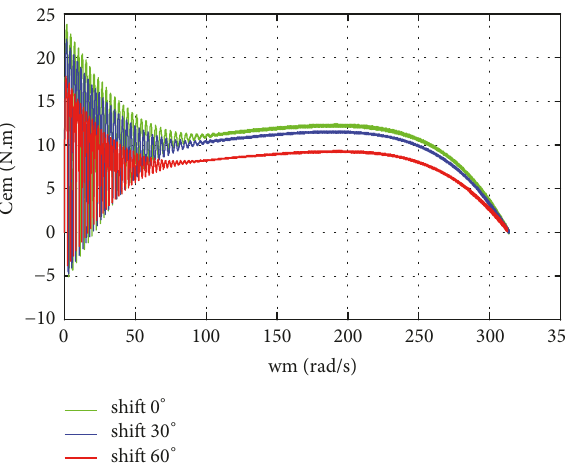
Figure 13: Torque-speed